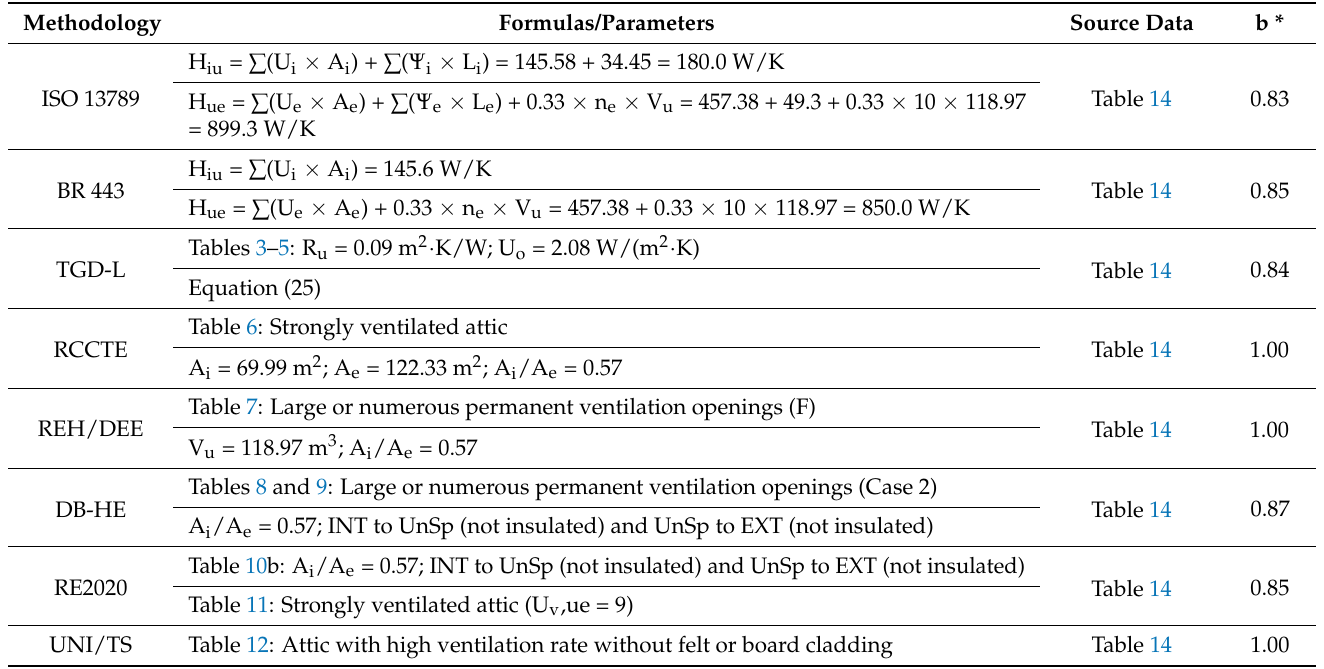
Table 18. Values of the estimated adjustment factor (b) for Attic 2.